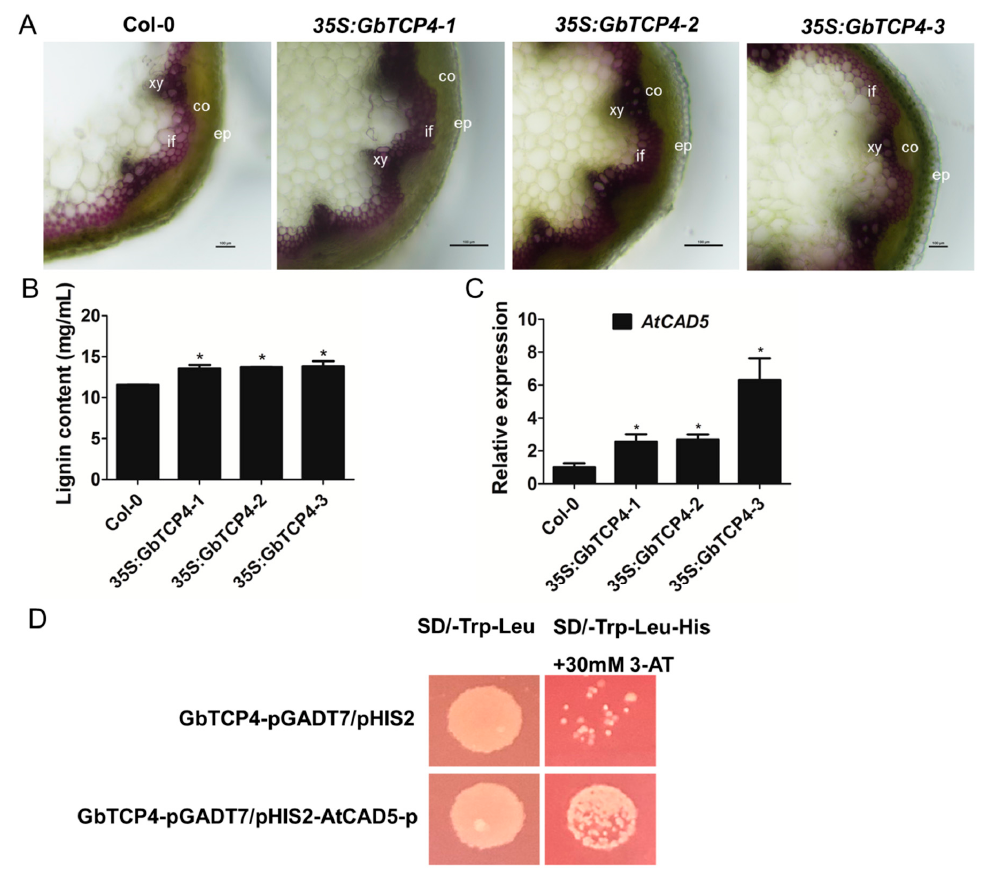
Figure 6. Constitutive overexpression of the GbTCP4 gene increases lignin content in transgenic Arabidopsis stems. ( A ) Phloroglucinol staining of stem cross-sections of the Col-0 and 35S:GbTCP4 transgenic lines. xy: xylem; if: interfascicular fibers; co: cortex; ep: epidermis; bars: 100 µm. ( B )